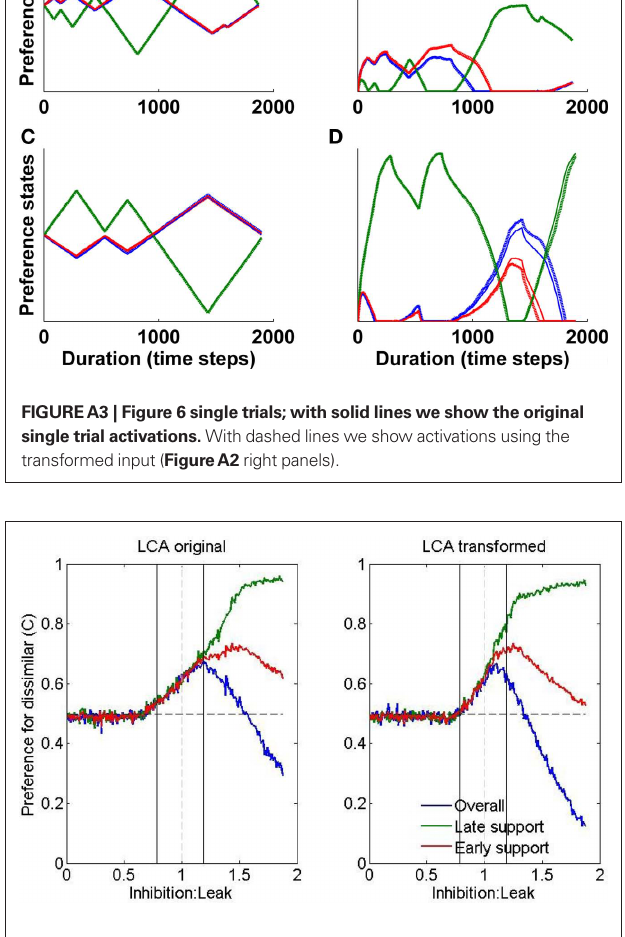
Figure A4 | Predictions of LCA for the similarity condition. In the left panel “LCA original” (as presented in Figure 8 ) and in the right, the same simulation is presented after applying the input transformation.